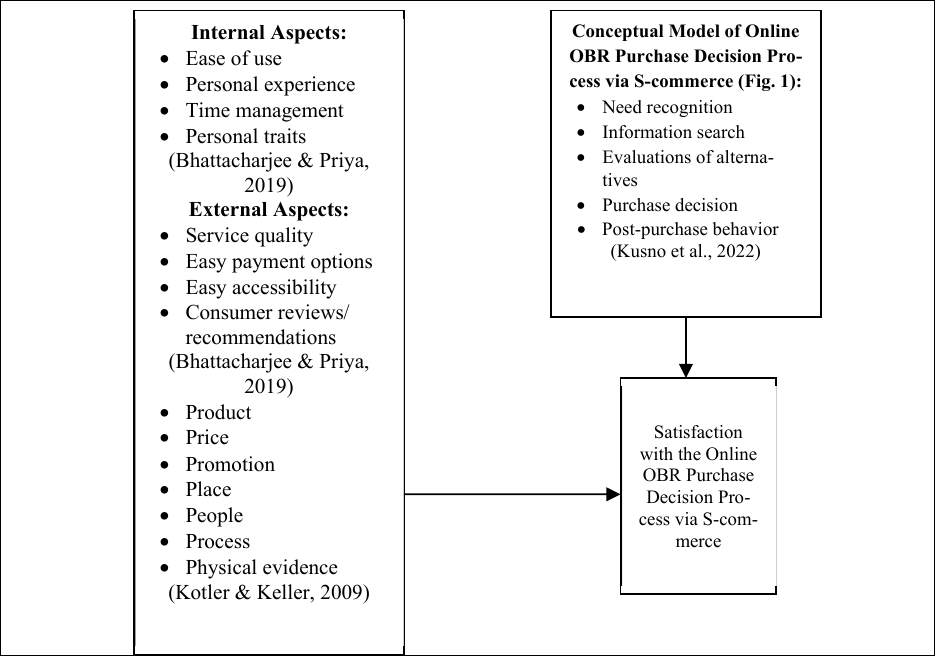
Fig. 2. Theoretical Framework